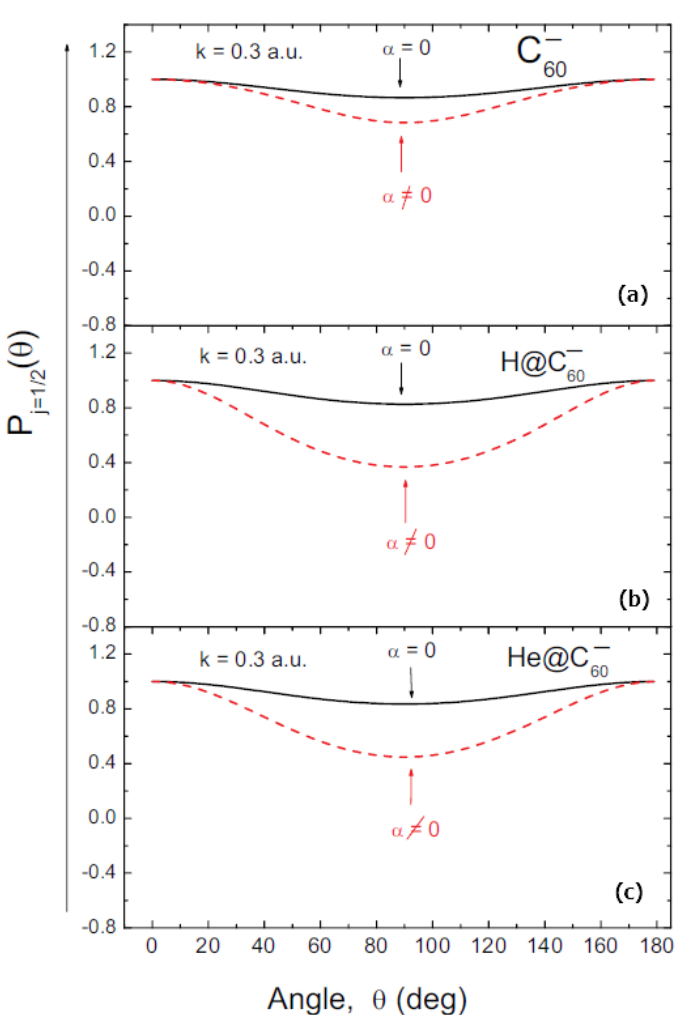
( θ ) , j = 1 2 ( 2 p ) , ( b ) H@C − ( 2 p ) and ( c ) He@C − ( 2 p ) calculated at k = 0.3 a.u. 60 60 60